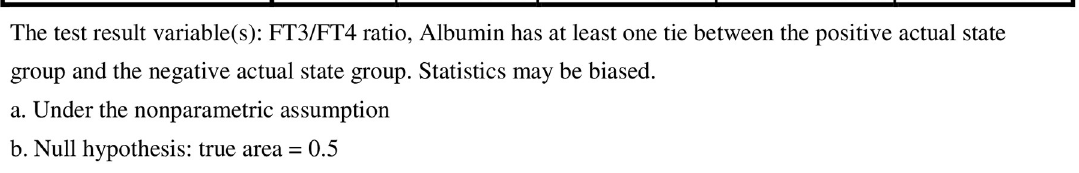
Fig 1. Roc analysis of FT3/FT4 ratio and albumin in 3 month mortality.